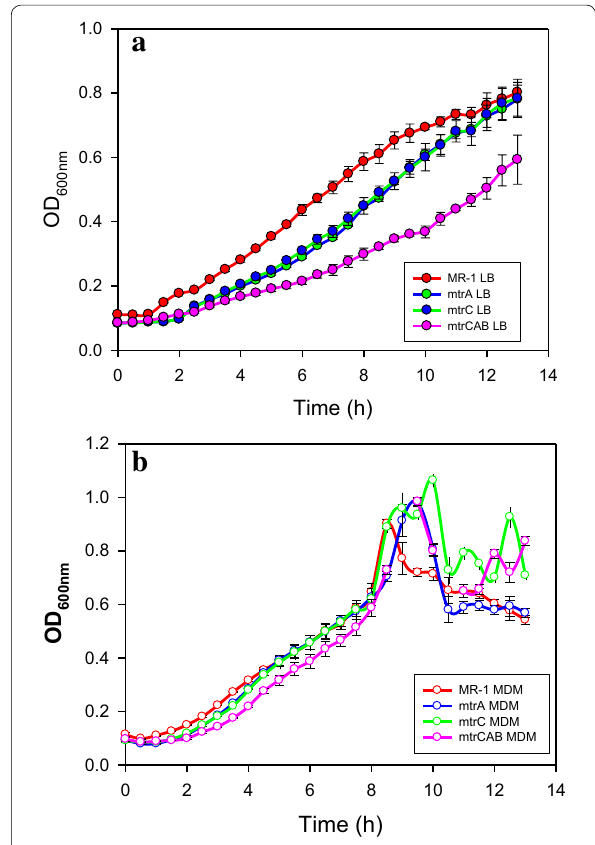
Fig. 4 Cell growth in a LB and b MDM medium. (red) Wild type MR‑1, (blue) mtr A, (green) mtr C, and (pink) mtr CAB genetic strains